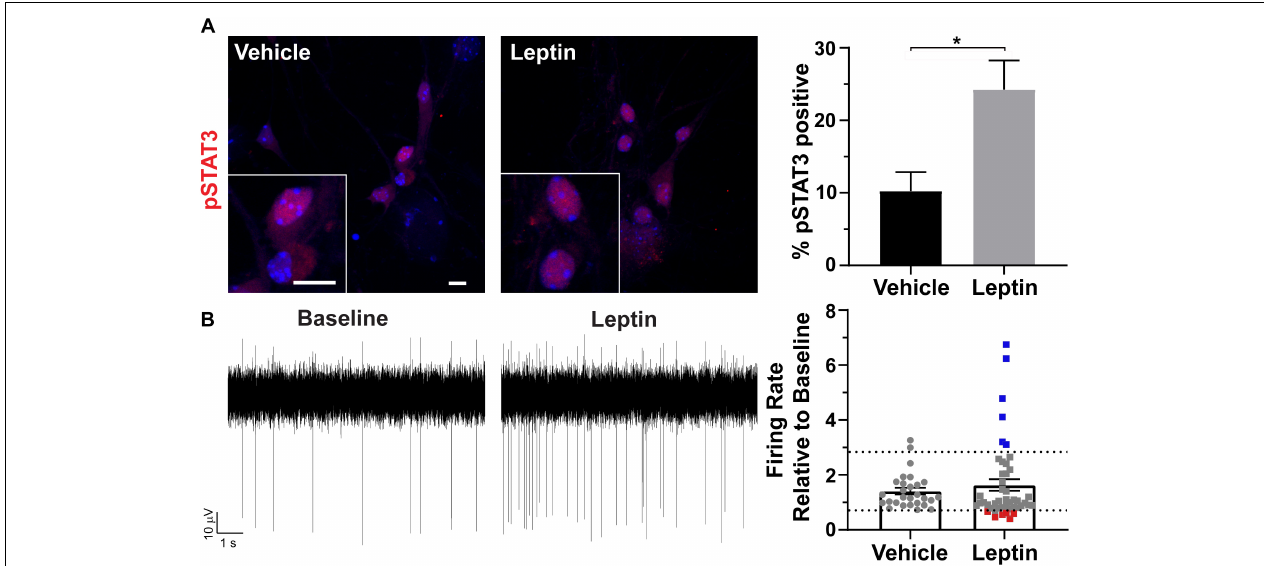
FIGURE 3 | Hypothalamic specific responses to leptin in vitro. (A) Phosphorylation and nuclear localization of STAT3 (pSTAT3, red) following 30 min leptin (10 nM) treatment. Hoechst stained nuclei are blue and scale bars are 10 µ m. Percent pSTAT3 positive cells in vehicle and leptin treated cultures divided by total number of cells counted is graphed as mean ± SEM. ∗ P < 0.05 using a Student’s t -test. Data collected from 3 hypothalamic samples from 3 experimental days. pSTAT3 positive cells/total vehicle treated hypothalamic nuclei 34/333, pSTAT3 positive cells/total leptin treated hypothalamic nuclei 86/354. (B) Representative traces from one electrode showing the baseline activity and activity after 10 nM leptin addition. The change in firing rate relative to baseline is graphed as mean ± SEM for vehicle and leptin addition. Each point represents an active electrode. Dashed line indicates two time above and below the average of the vehicle bar. Leptin results in some electrodes displaying decreases (red squares), increases (blue squares), or no change (gray squares) in neuronal activity relative to baseline. Data collected from 4 hypothalamic samples from 3 experimental